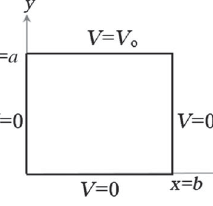
FIG. 1. An example of a canonical exam problem targeting Cartesian SOV. Variations on this question in our data include providing a nonconstant potential on the fourth side [e.g., ð x; y ¼ a Þ ¼ V V sin π x=a ], placing the nongrounded side at o o y ¼ 0 rather than y ¼ a , or placing one of the grounded sides at infinity.